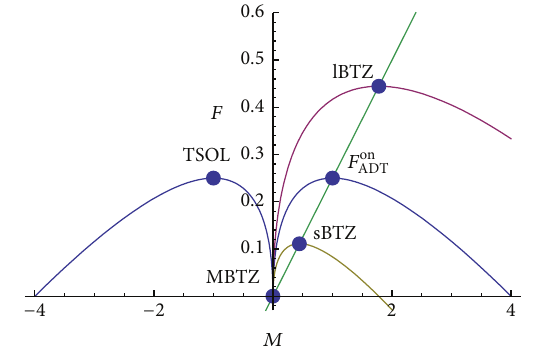
Figure 3: On-shell free energy 𝐹 on ADT (𝑚 2 = 0.4,𝑀) = 0.25𝑀 for the BTZ and 𝐹 TSOL ADT (𝑚 2 = 0.4) = 0.25 for TSOL. Three off-shell free energies for the BTZ are given by 𝐹 off ADT (𝑚 2 = 0.4, 𝑀,𝑇) for 𝑇 = 𝑇 1 = = 1/2𝜋 ,and 𝑇 = 2/3𝜋 .Ontheotherhand,theoff-shellfree 1/3𝜋, 𝑇 𝑐 2 energy for TSOL is 𝐹 off TSOL (𝑚 2 = 0.4, 𝑀) . Here, we observe that the MBTZ located at 𝑀 = 0 is the ground